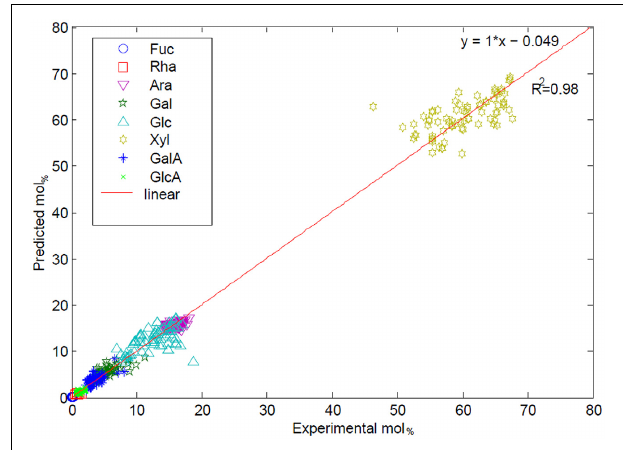
FIGURE 2 |A correlation analysis predicted (PLS model of FT-NIR) versus experimentally determined monosaccharide composition (mol%) of rice leaf samples. The correlation coefficient between experimental and predicted values was calculated to be R 2 = 0.98 as reproduced from literature (Agblevor etal., 1994; Smith-Moritz etal.,